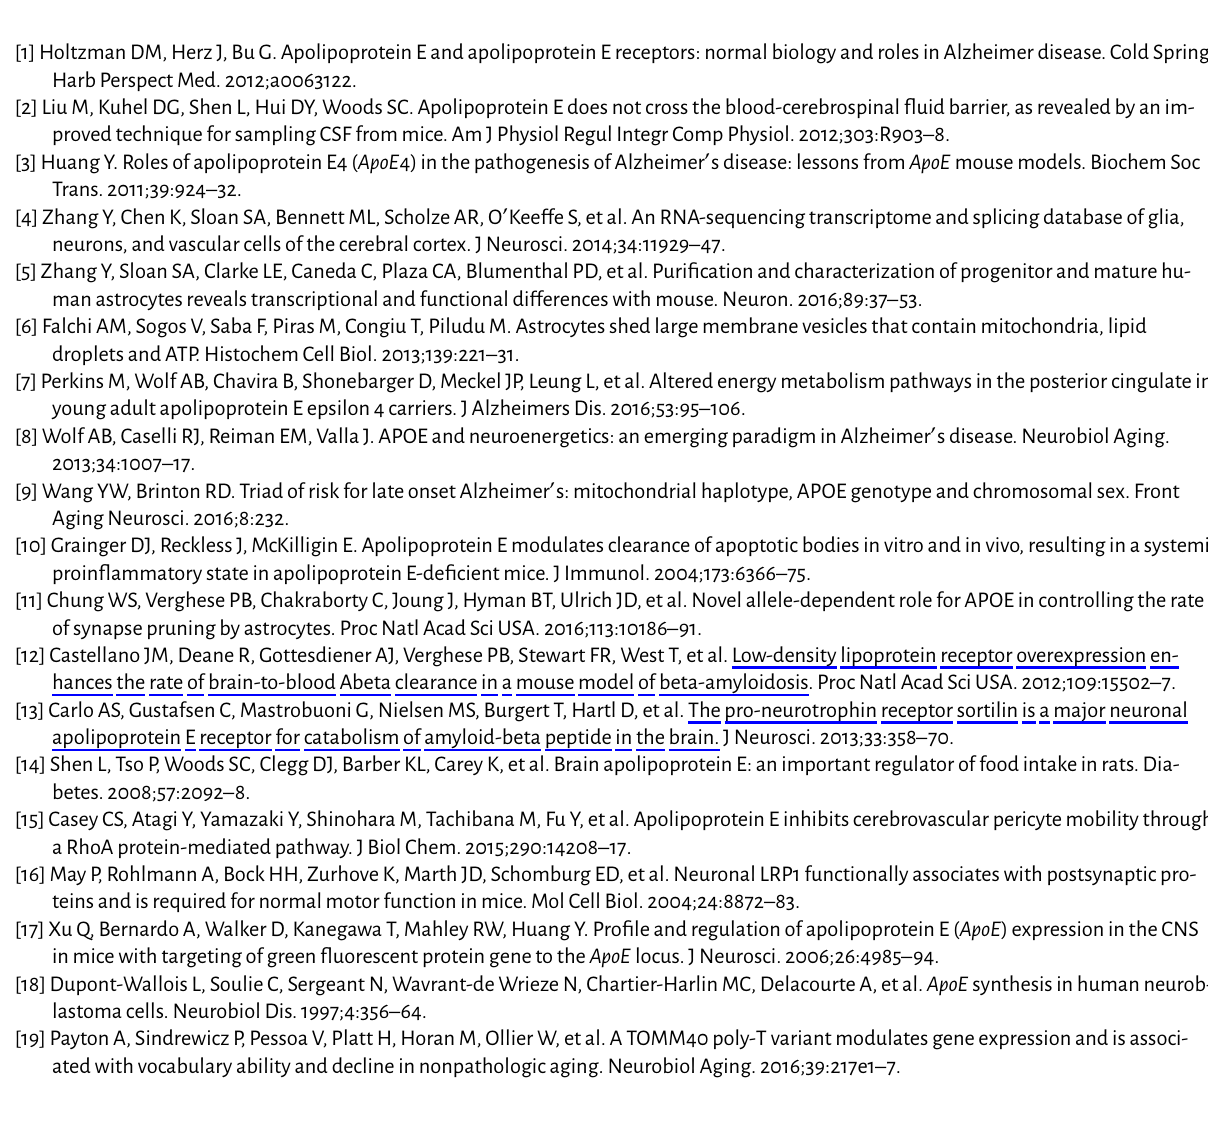
c. The Apoe expression elevation in mice under social stress (Supplementary Table 1) impacts the neighboring genes apparently in a non-specific manner. The covariation of Bcam , Pvrl2 , Tomm40 , Apoc1 , and Clptm1 , listed in Table 4, results in the following corresponding p -values: 1.37E − 08, 7.88E − 09, 2.96E − 07, 4.85E − 06, 8.63E − 06. In the hypothalamus only, the corresponding values are: 3.14E − 08, 4.29E − 14, 1.35E − 13, 0.226,